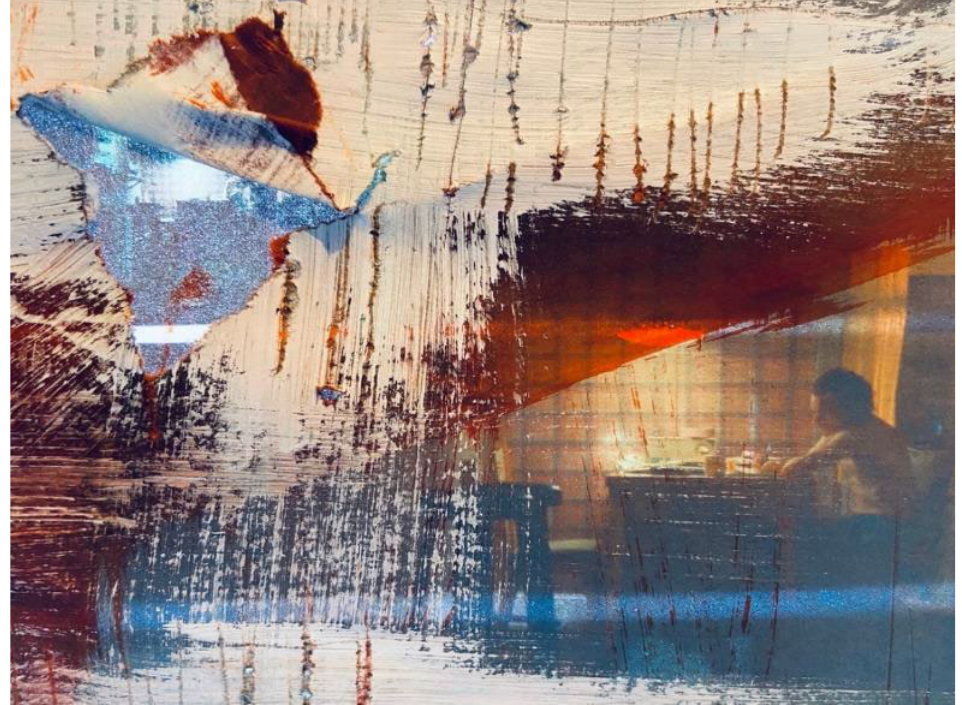
Figure 51 Journal Collage 2: Exposed layers of intrusion on Arthur’s